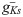
Reducing slow potassium conductance increases network sensitivity to heterogeneities in synaptic coupling.(A.) The transition from stationary to moving bump dynamics is demonstrated by ϕ, normalized preference for heterogeneity. Increasing gKs¯ rapidly reduces the preference for an area with a 10% increase in strength of recurrent excitatory connections. (B.) Significantly enhanced heterogeneities are able to act as an attractor of network activity even for networks with high levels of SFA with a significant preference apparent up to gKs¯ = 0.75 mS/cm2. (C.) Network preference manifests as longer upstates within the heterogeneous zone than outside it. (data are mean ± s.e.m).